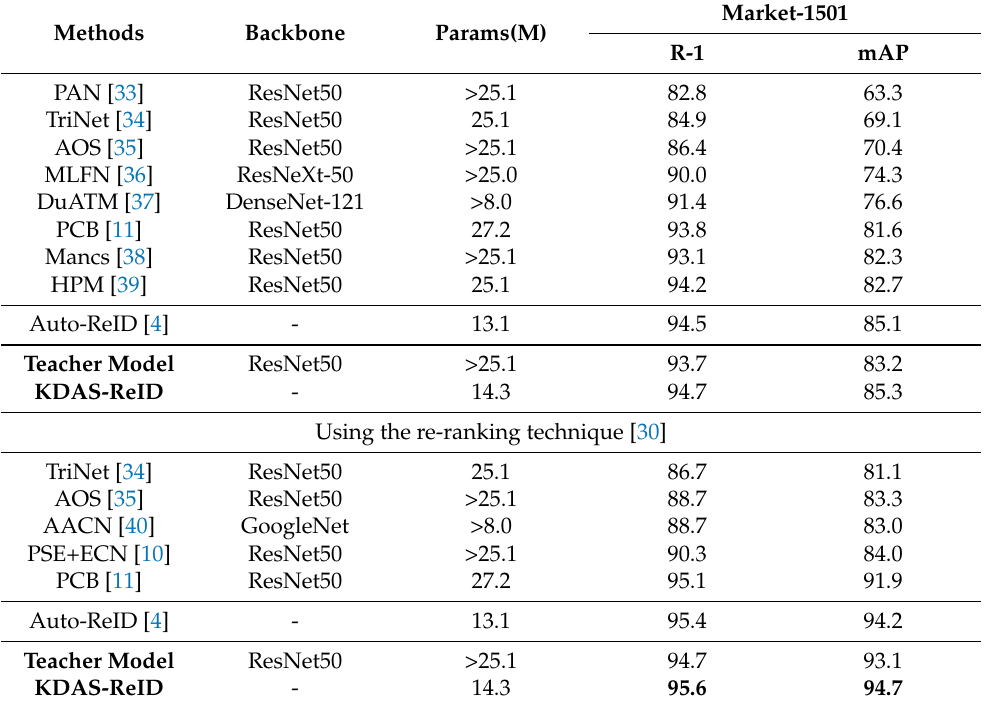
Table 2. The current state-of-the-art model is compared with our model on the Market-1501 dataset. We compare each model in terms of parameters, R-1 (Rank-1) accuracy, and mAP. We have boldfaced the best results in the